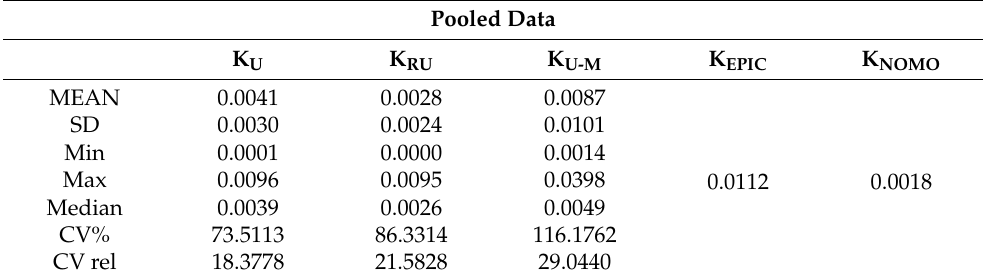
Table 3. Different soil erosion models and their calculated K-values from the measured parameters of each rainfall simulation (K U —USLE; K RU —RUSLE; K U-M —ULSE-M; K EPIC —EPIC nomograph equation; K NOMO —USLE nomograph